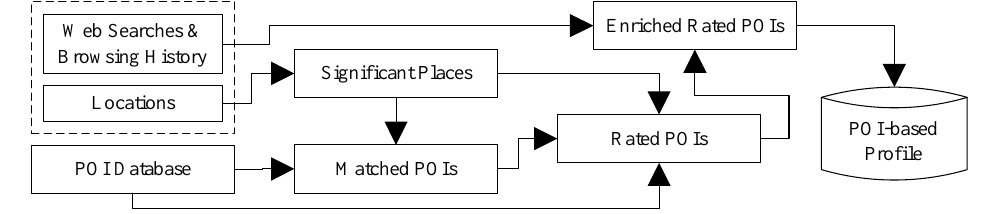
Figure 3. The flowchart of the profiling process.